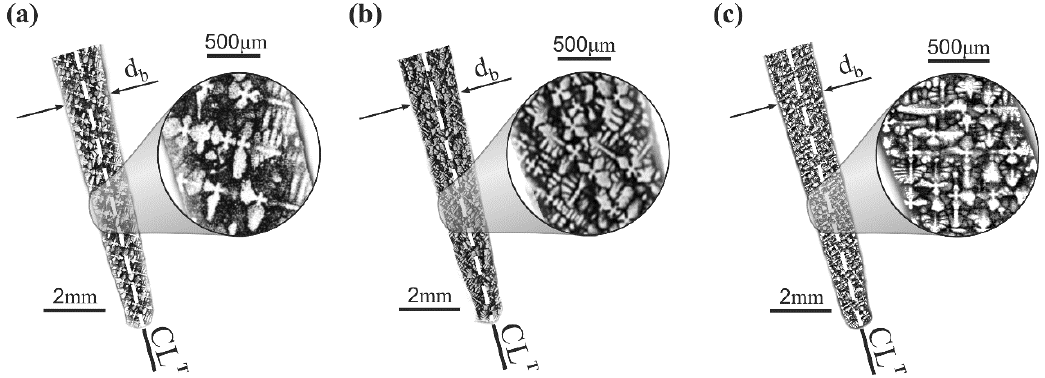
Figure 2. Exemplary dendritic structures of ML thin-walled airfoil area of blades produced at withdrawal rate of ( a ) 2 mm/min.; ( b ) 3 mm/min.; and ( c ) 4 mm/min. (SEM, BSE technique).